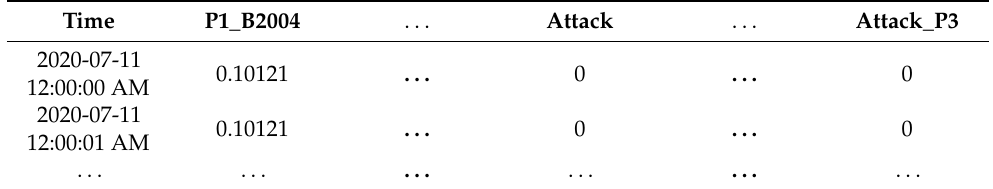
Table 6. HAI version 21.03 training data (921,603 rows × 84